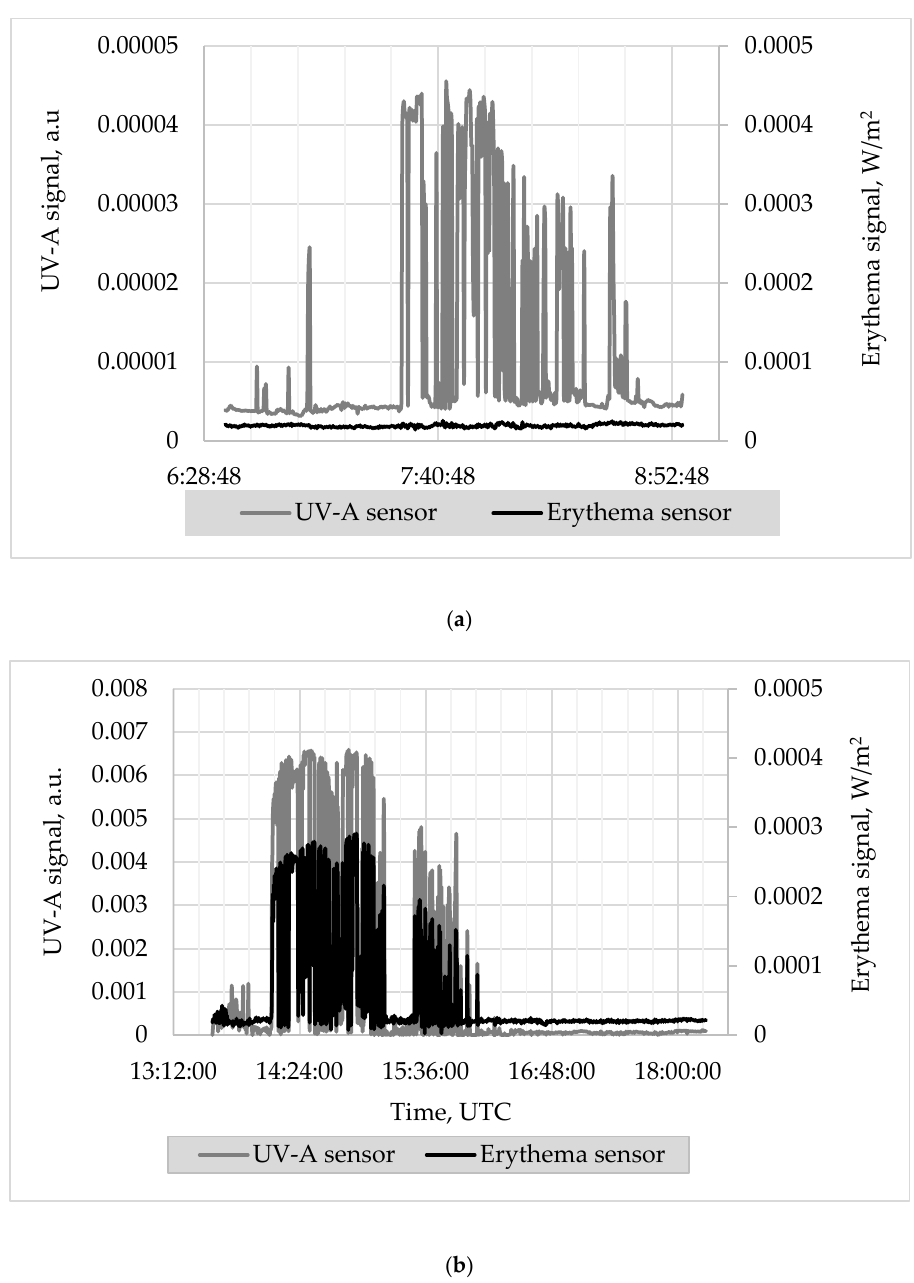
Figure 3. Signals from UV-A and erythema effective sensors of the Genesis-UV unit measured during two different flights: ( a ) morning outbound flight to Barcelona: low ultraviolet radiation may be due to high UV attenuating windshield or use of visors; ( b ) outbound flight to Tenerife: high UVR, aircraft with high UVR transmitting windshield, no visors.